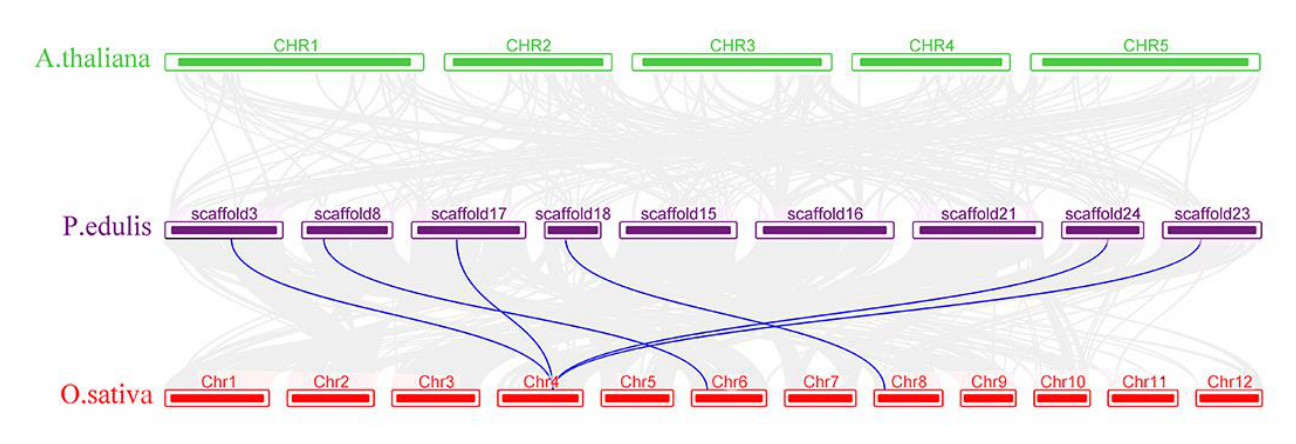
Figure 5. Syntenic relationships between PeSERKs in moso bamboo and SERK genes in two representative plant species. Gray lines in the background indicate the collinear blocks within P. edulis and other plant genomes. Blue lines indicate the syntenic SERK gene pairs.